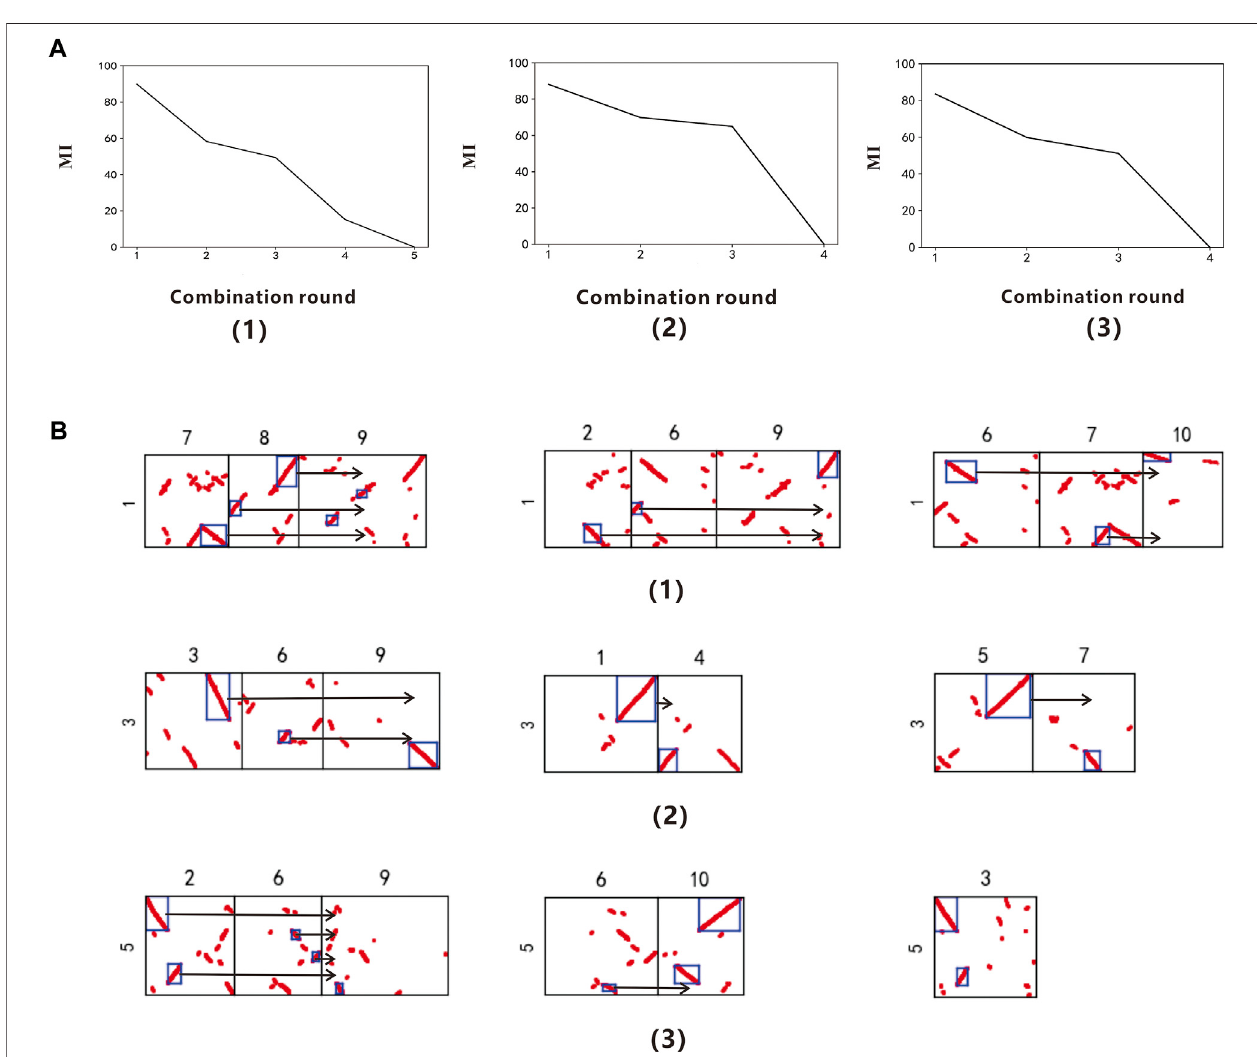
FIGURE 3 | (A) Collinearity evaluation index line chart of Arabidopsis thaliana Chr.1, Chr.3 and Chr.5 (B) Combination fi gure of Brassica rapa polyploidy. (A,B) correspond to each other. (1) The Arabidopsis thaliana chromosome 1 (2) The Arabidopsis thaliana chromosome 3 (3) The Arabidopsis thaliana chromosome 5